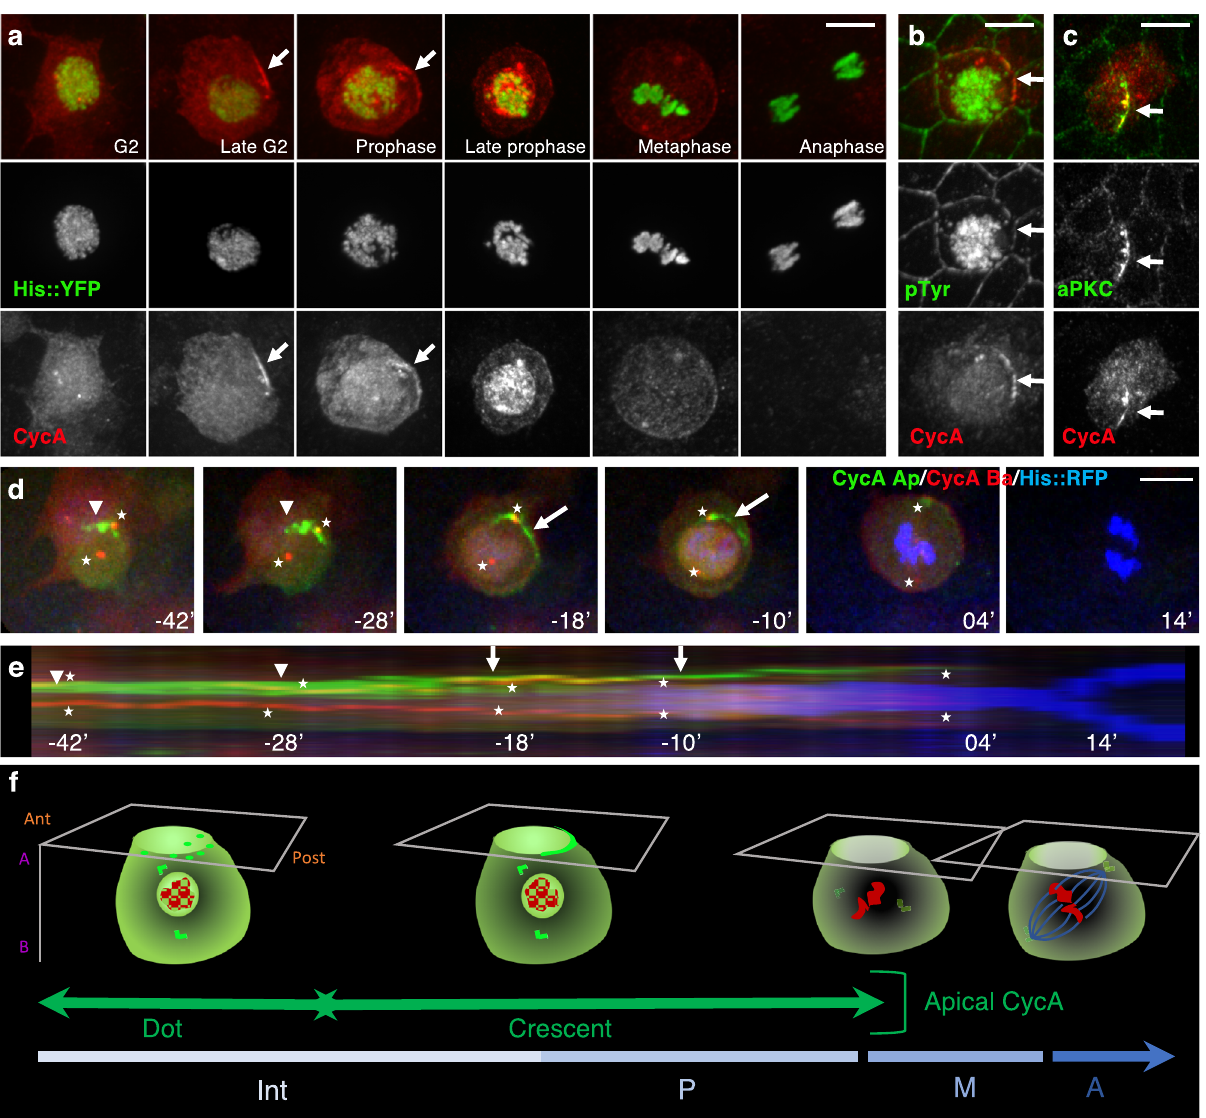
Fig. 1 CycA is asymmetrically localized during pI mitosis. a Intracellular localization of CycA. Endogenous CycA revealed by immuno fl uorescence in red. Sensory cells are identi fi ed using neur > H2B::YFP (green) which also shows the condensed state of DNA during mitosis. Note that CycA forms a crescent (arrows) in the posterior cortex of the pI cell at the end of G2 phase and at the beginning of prophase. Bottom panels, separate color channels shown in grayscale ( n = 8). b , c Apical section of pI cells. CycA (red) is localized in the apical-posterior region of the cortex (arrows) during pI mitosis as revealed by its colocalization (green) with pTyr ( b , n = 3) and aPKC ( c , n = 4). d Snapshots of 4D live imaging of CycA::eGFP. Pools of apical and basal chimeric CycA are arti fi cially separated (CycA Ap, green; CycA Ba, red) with chromosomes labelled with H2B::YFP (blue). Arrowheads point to accumulation of CycA dots in the apical part of the cell, arrows indicate the apical-posterior crescent, stars show the centrosomes. Time is given in minutes relative to the onset of metaphase. e Kymograph of the pI cell shown in D, built along a line passing through the apical pole of the pI cell from G2 phase onwards. Note that accumulation of apical-posterior dots (arrowheads) occurred before the formation of the CycA crescent (arrows). Stars indicate centrosomes. f Schematic view of CycA (green) during pI mitosis showing DNA (red) and the mitotic spindle (blue). Ant, anterior; Post, posterior; A, apical; B, basal. Anterior is to the left in a , b , c and f and to the bottom in d and e . Scale bars, 5 μ